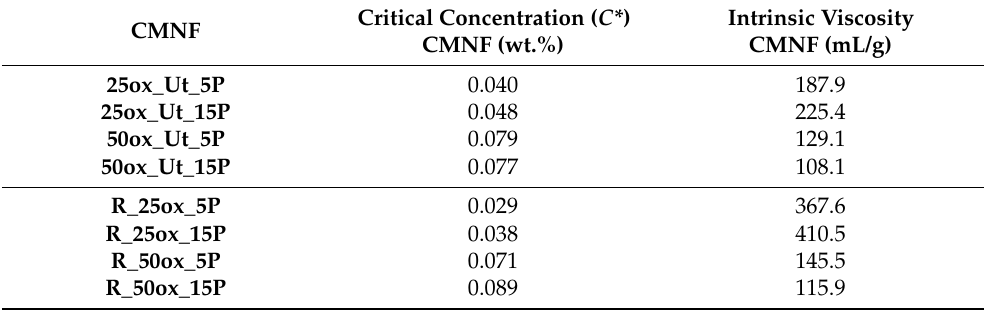
Table 7. The critical concentration ( C* ) and intrinsic viscosity of CMNFs